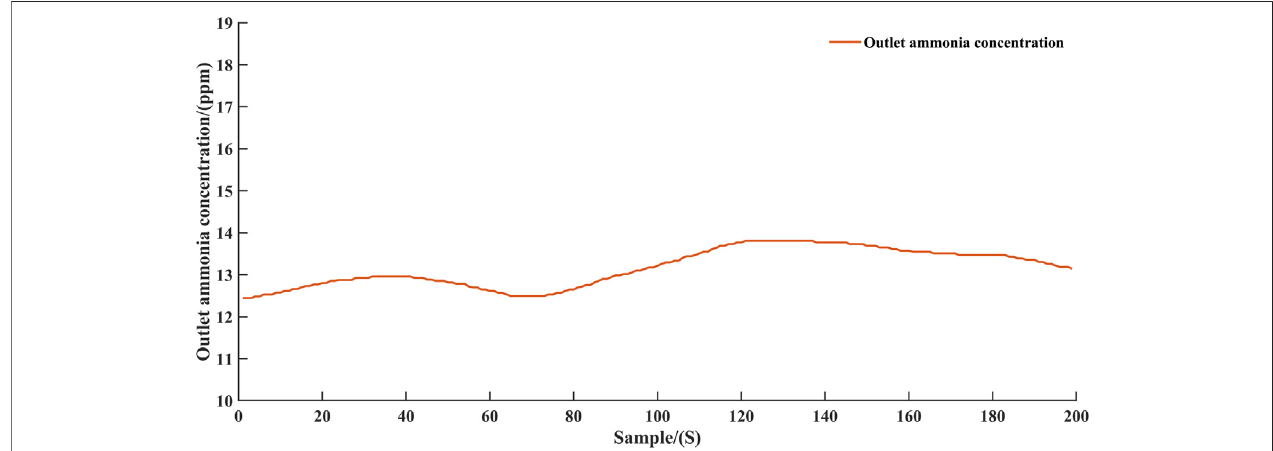
FIGURE 11 | Ammonia concentration at the outlet of reactor controlled by agent